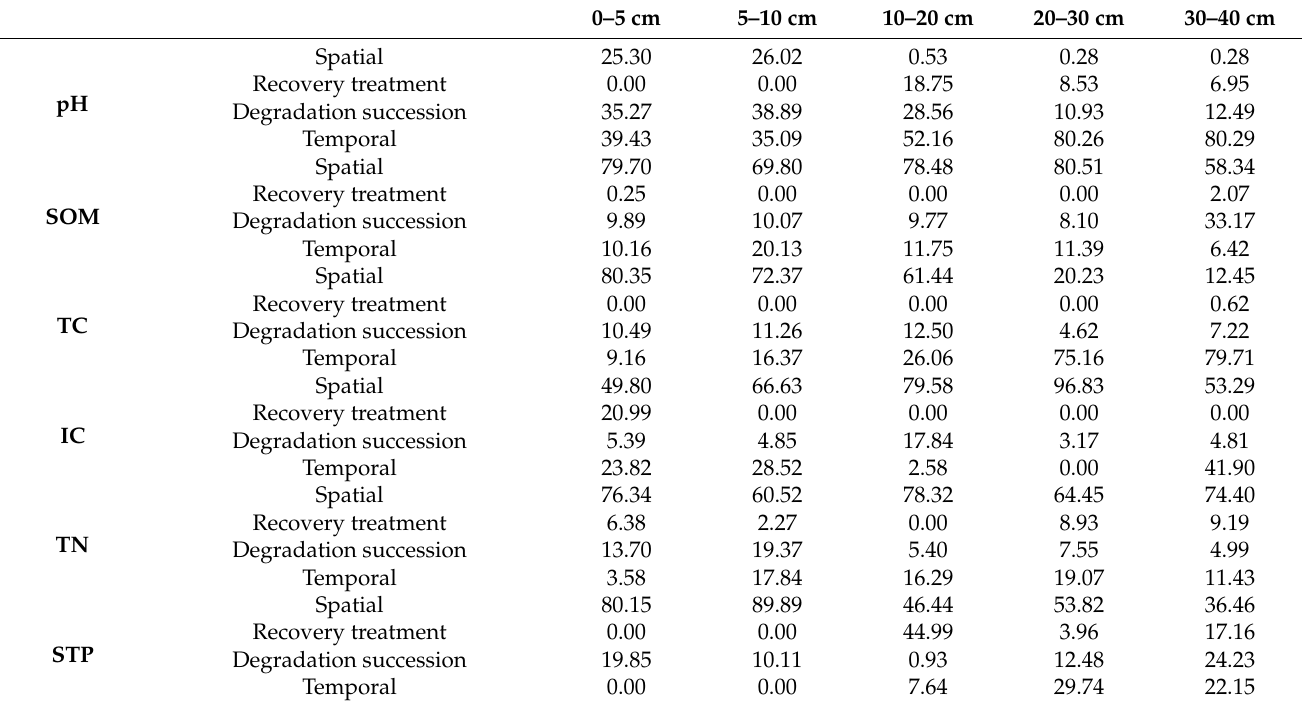
Table 3. Multivariable analysis of soil nutrient